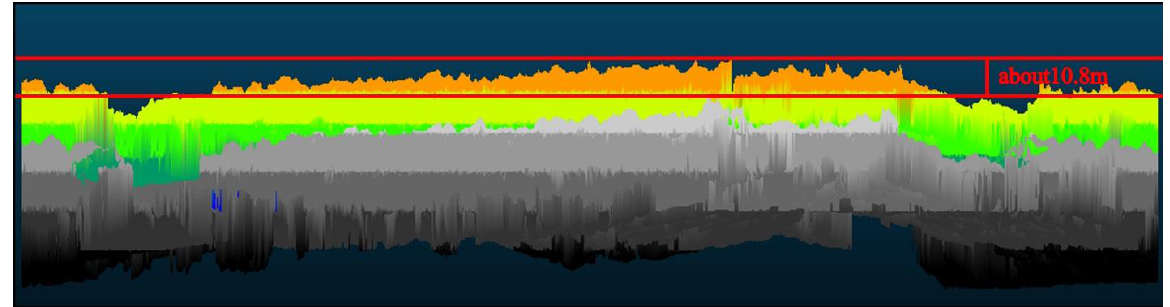
Figure 11. The side view intuitively reflects the height difference between the surface model of O and OT30, where the colored area is OT30 and the gray area is O.